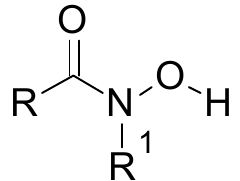
Figure 1. Hydroxamic acid , with R and R 1 as organic residues and CO as a carbonyl group. They are amides (RC(O)NHR’), wherein the NH center has an OH substitution.